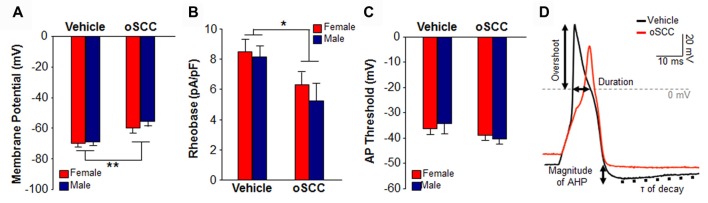
Neuronal sensitization during the progression of 4NQO-induced oral carcinogenesis. Excitability was quantified with resting membrane potential (A), rheobase (B) and action potential (AP) threshold (C) in trigeminal ganglia (TG) neurons from vehicle-treated mice and 4NQO-treated female (red bars, N = 4) and male (blue bars, N = 6) mice with oSCC. P > 0.05 for Sex vs. Treatment by Two-way ANOVA. Pooled neurons from female and male mice with 4NQO-induced oSCC had significantly depolarized membrane potential and significantly decreased rheobase. *P < 0.05, **P < 0.01 vs. vehicle-treated by Unpaired Student’s t-test. (D) A representative plot of depolarization (4 ms) evoked AP from a vehicle-treated (black) female mouse and a female mouse with 4NQO-induced oral oSCC (red) showing how we defined the active electrophysiological properties analyzed in Table 1. AHP is afterhyperpolarization; τ is time constant of AHP decay.